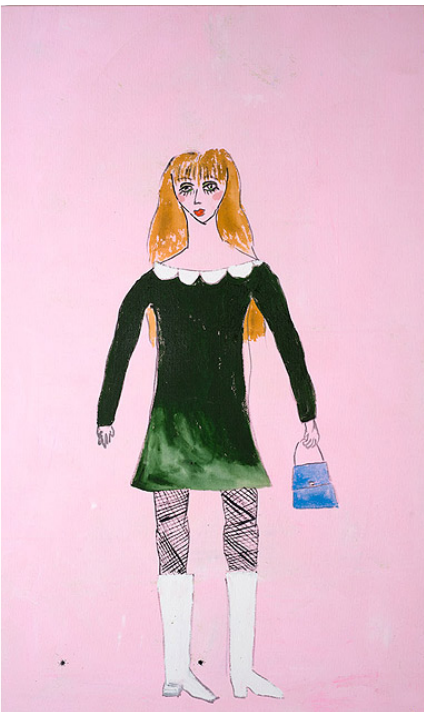
Jenny Watson, 60s Dolly Bird , 2014, Japanese pigment tinted gesso and acrylic on 10gsm cotton duck, 160 × 95cm. Courtesy Roslyn Oxley Gallery. Copyright: Jenny